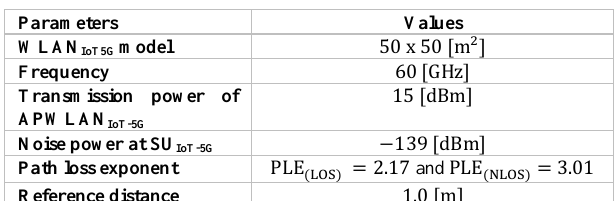
Table 2 . PS 5G sensing scenarios in WLAN IoT-5G .